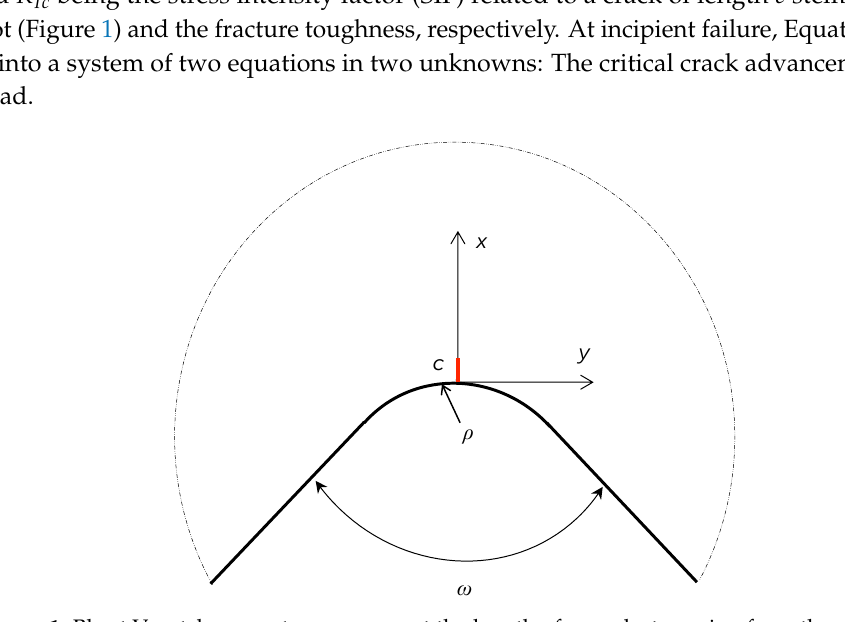
Figure 1. Blunt V-notch geometry: c represent the length of a crack stemming from the notch